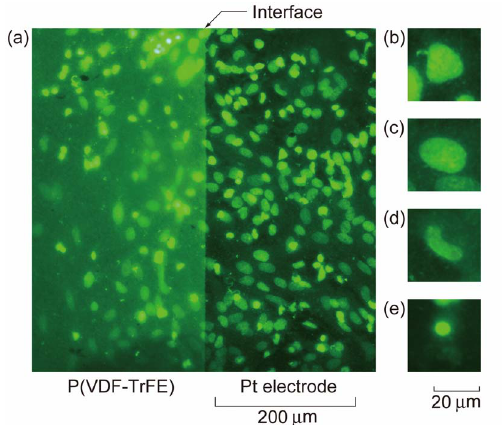
Fig. 4 (a) Fluorescent photograph of cultured neurons over P(VDF-TrFE) film and Pt electrode modified by fibronectin on Si substrate; (b)~(d) distorted stained area corresponding to living neurons and (e) circular area corresponding to dead